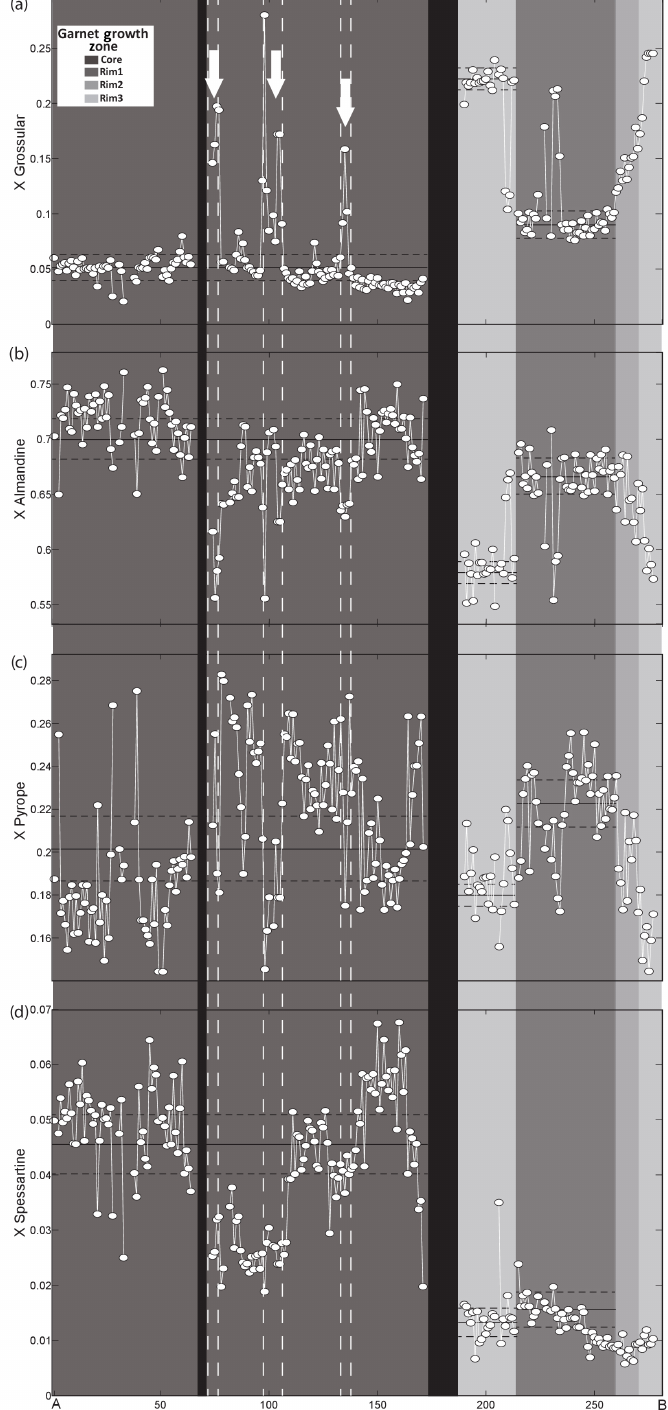
Figure 8. Garnet endmember proportions along 300µm profile (trace shown in Fig. 7) in sample FG1249. Note different mole fraction scales. Late chlorite fractures are highlighted by black bands. The fractures in the core, sealed by a garnet with different composition, are indicated by white arrows. Mean compositions are represented by black solid lines with the standard deviation (1 σ ) represented by the dashed black lines. (a) Grossular. (b) Almandine. (c) Pyrope. (d) Spessartine. The distinction of each garnet growth zone is based on its grossular content with the aim of helping the